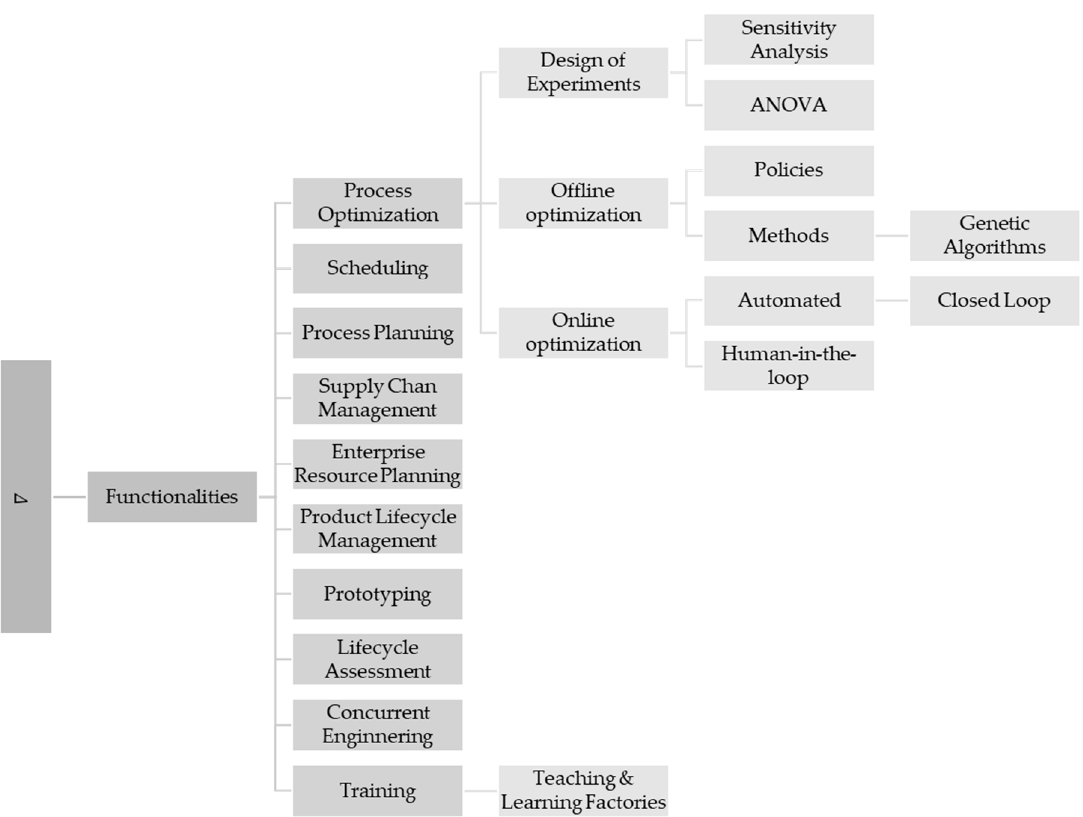
Figure A7. Technologies’ classification: Functionalities-related branch.